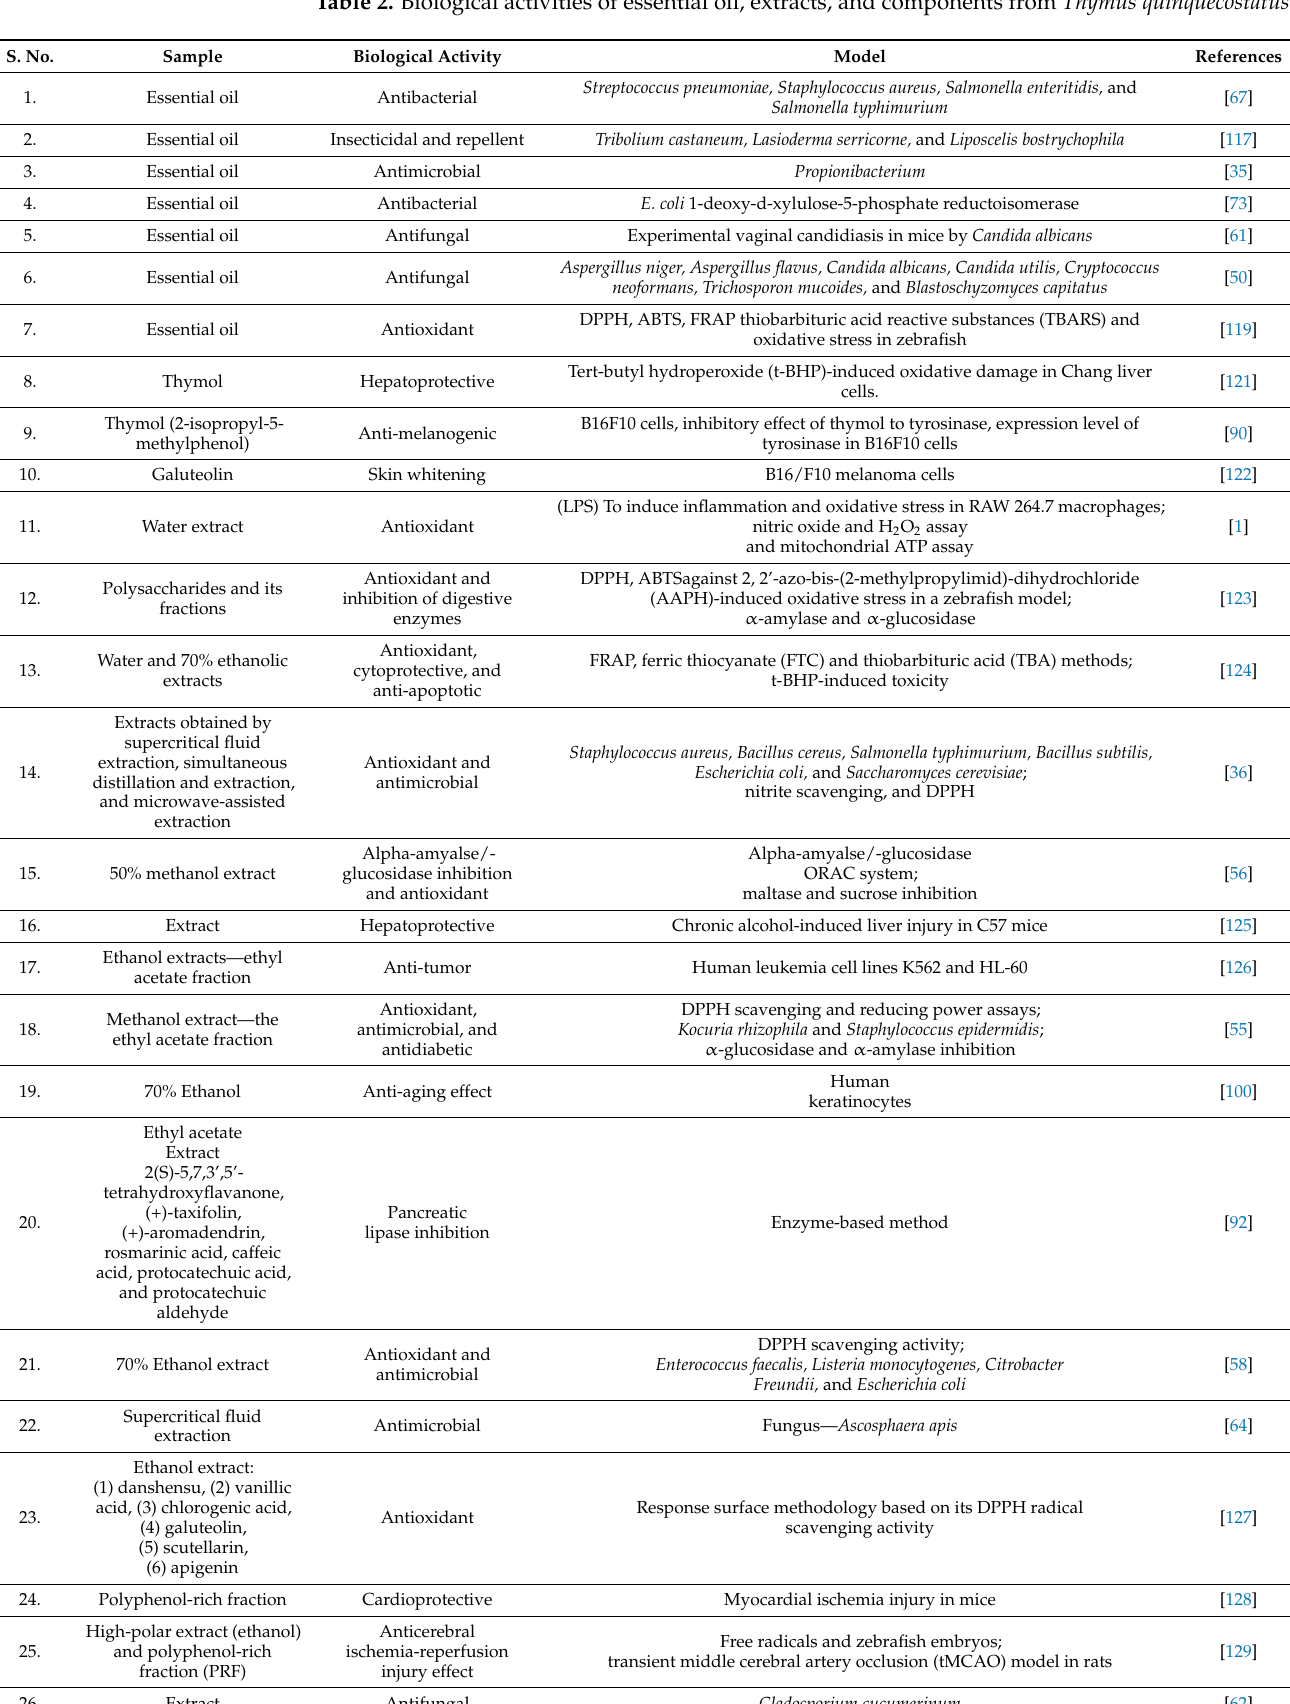
Table 2. Biological activities of essential oil, extracts, and components from Thymus quinquecostatus